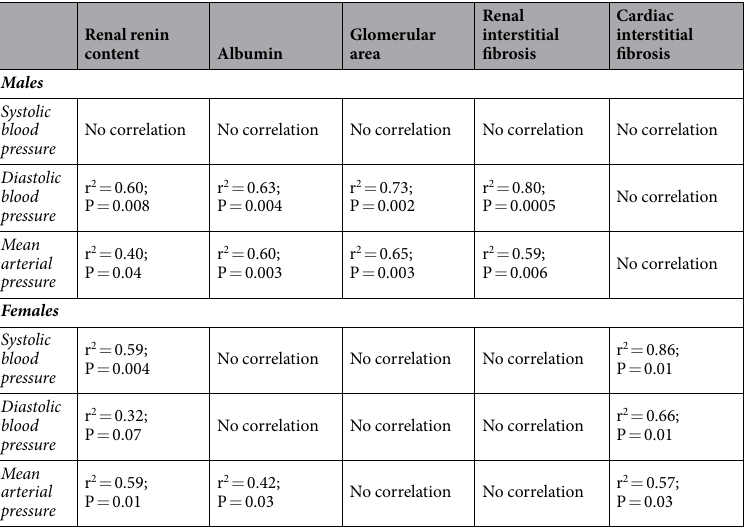
Table 3. Correlation analysis of blood pressure and renal/cardiac parameters in 12-month-old